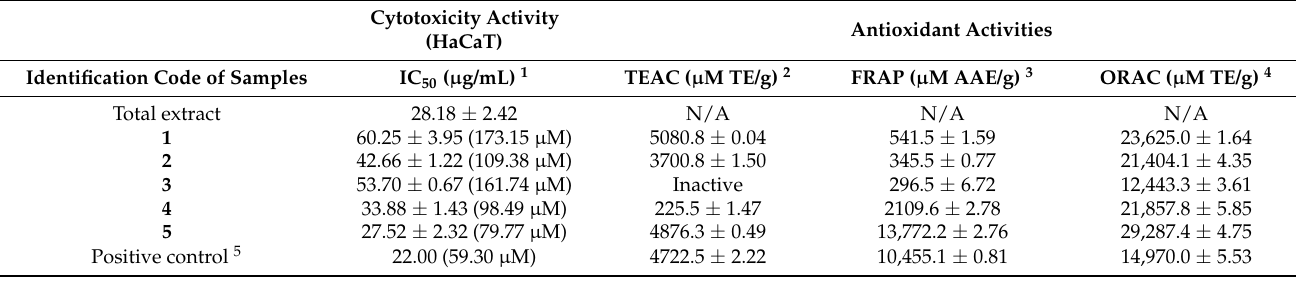
Table 4. The cytotoxic and antioxidant activities of the P. madagascariensis isolated